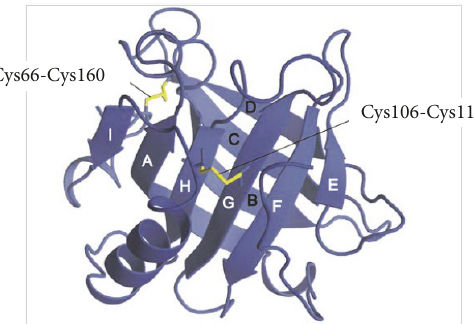
Figure 1: Structure of 𝛽 -Lg . Yellow lines represent disulfide bonds (adapted from Ikeguchi